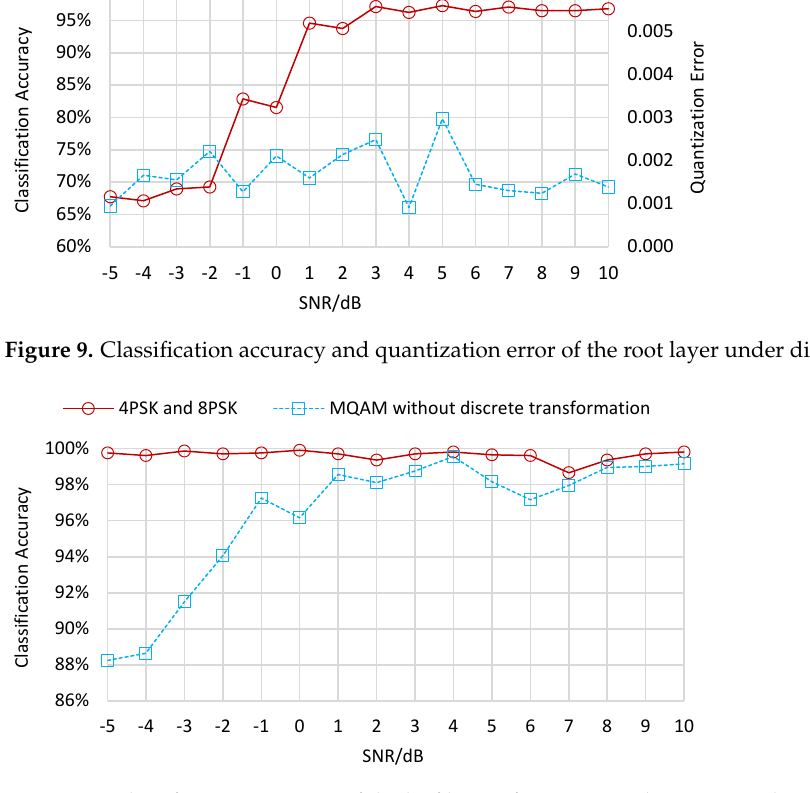
Figure 10. Classification accuracy of the leaf layers for MPSK and MQAM without discrete transfor- mation under different